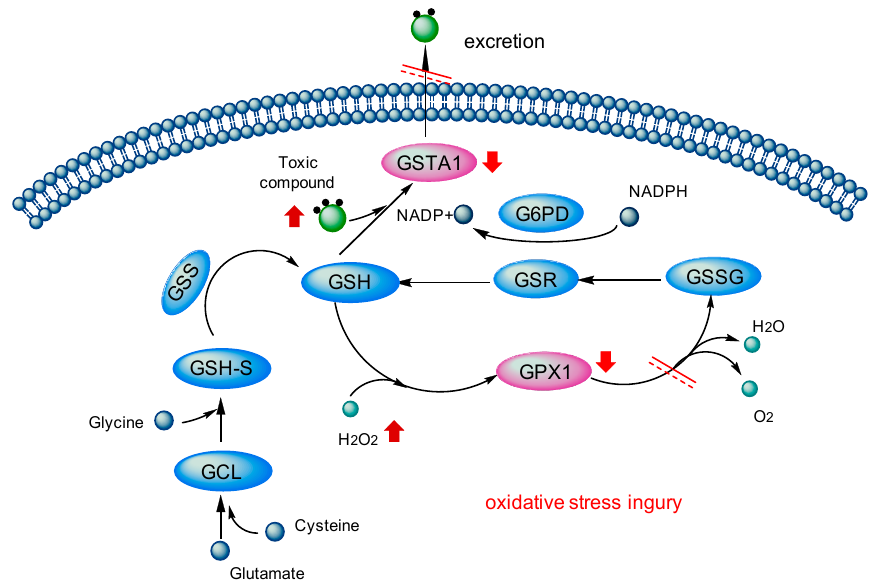
Figure 4. Toxicity mechanism of PAs in glutathione metabolism: downward red arrows stand for the decrease of the activities, upward red arrows for the increase of the activities, black arrows for the direction of biological reactions and red double lines mean this pathway is blocked.